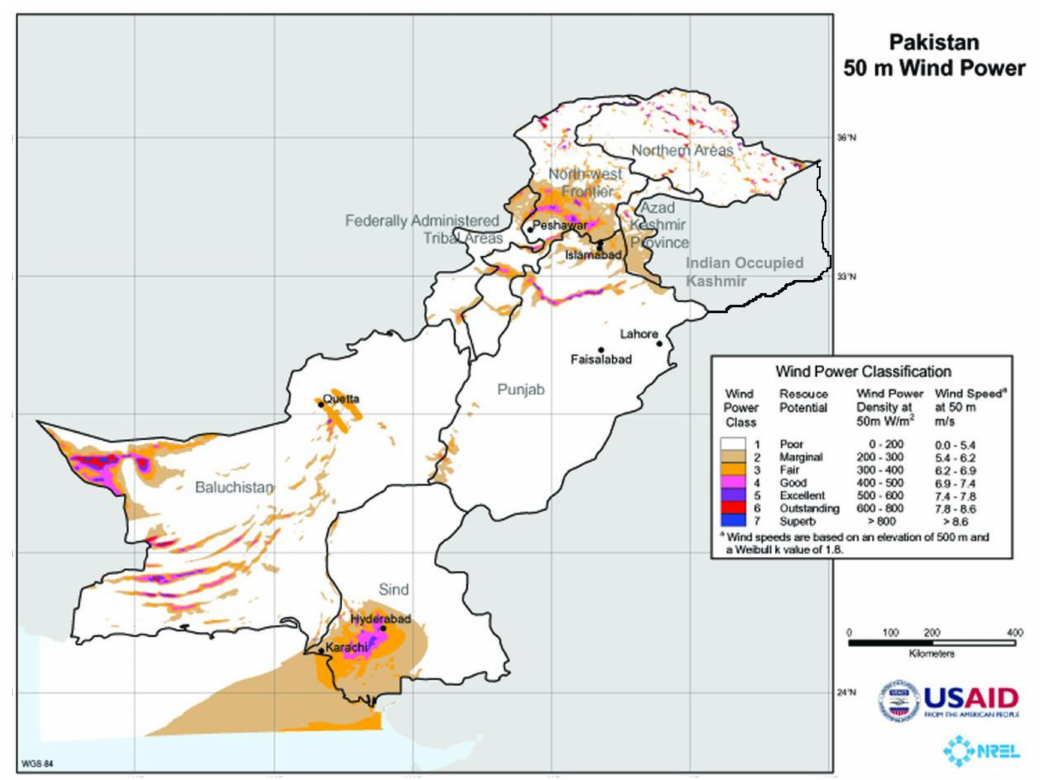
Figure 9. Wind energy potential of Pakistan